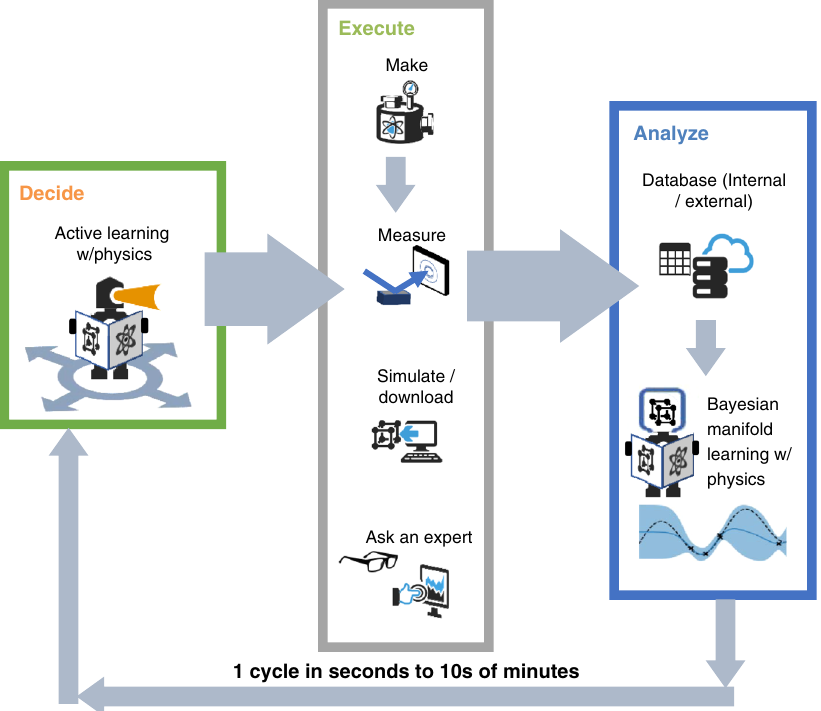
Fig. 1 Closed-loop autonomous materials exploration and optimization (CAMEO). The autonomous cycle begins with loading data from databases including composition data for the materials on the composition spread and computed materials data from the AFLOW.org 41 density functional theory database. The collected data is then used to begin analysis of the data using physics-informed Bayesian machine learning. This process extends knowledge of structure and functional property from materials with data to those without, predicting their estimated structure and functional property, along with prediction uncertainty. Physics-informed active learning is then used to identify the most informative next material to study to achieve user-de fi ned objectives. For this work, active learning can select the next sample to characterize through autonomous control of the high-throughput X-ray diffraction system at a synchrotron beamline or it can (optionally) request speci fi c input from the human-in-the-loop. Future implementations will include autonomous materials synthesis and simulation. The data collected from measurements and from human input are added to the database and used for the next autonomous loop. For more information, see “ Methods ”